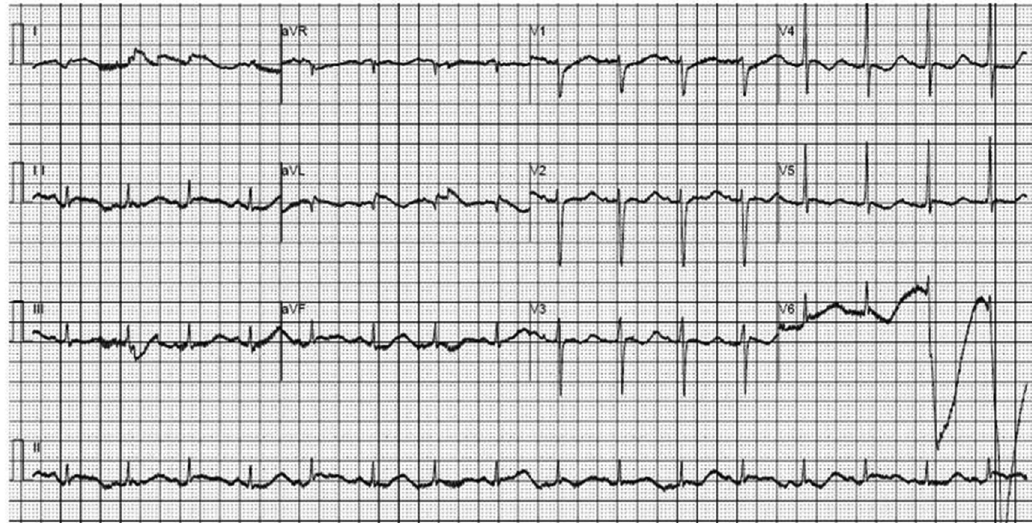
Figure 1: Electrocardiogram suggested mild ST - segment elevation in leads the caVL, reciprocal ST depressions in V4 –